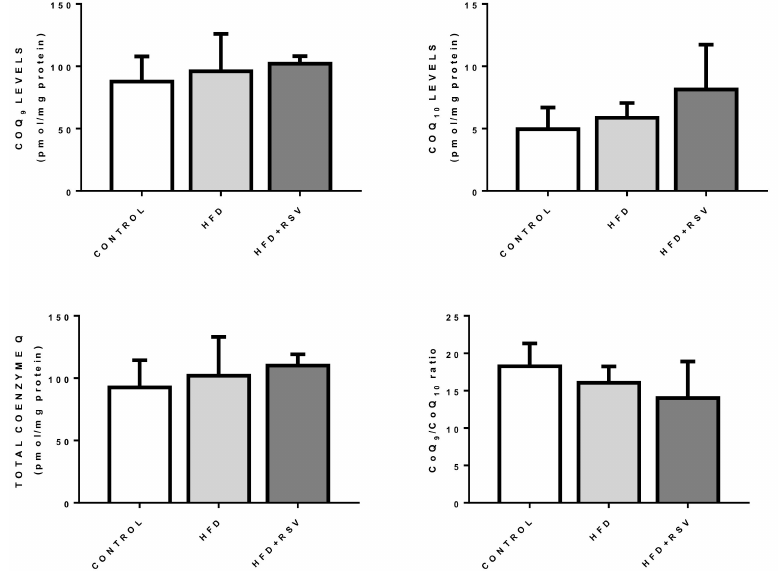
Figure 4. CoQ 9 and CoQ 10 levels in mouse liver. Figure represent the levels of CoQ 9 , CoQ 10 , total CoQ and ratio CoQ 9 / 10 in whole homogenate of liver ( n =